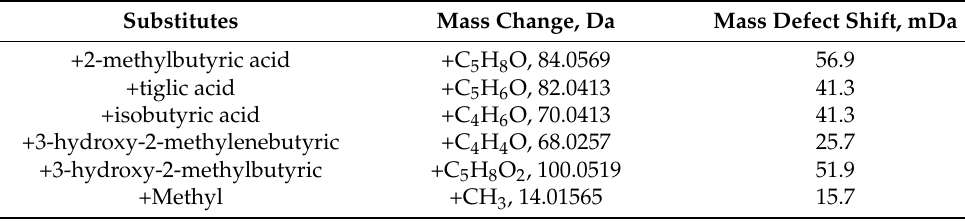
Table 2. Transformations on resin glycosides.